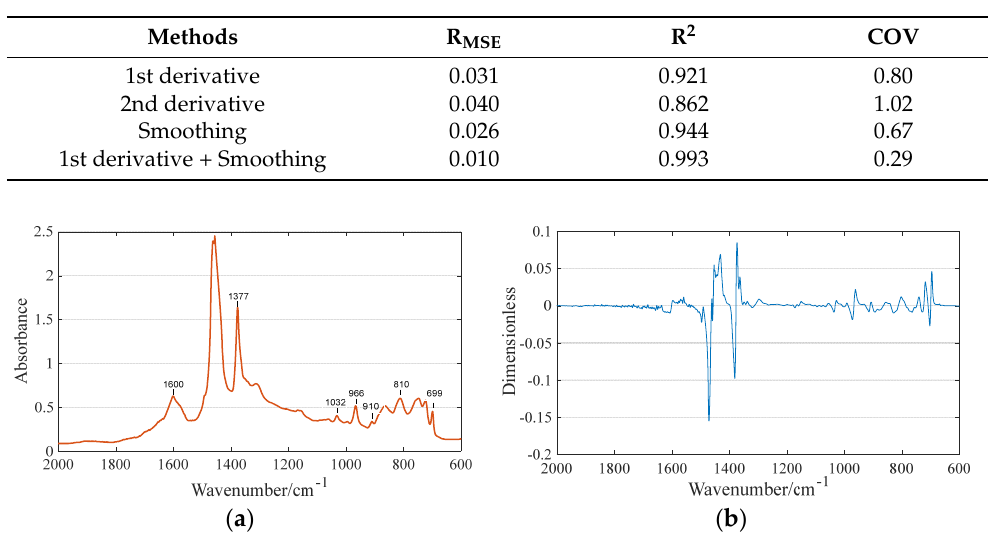
Table 3. Contrast of varying methods.